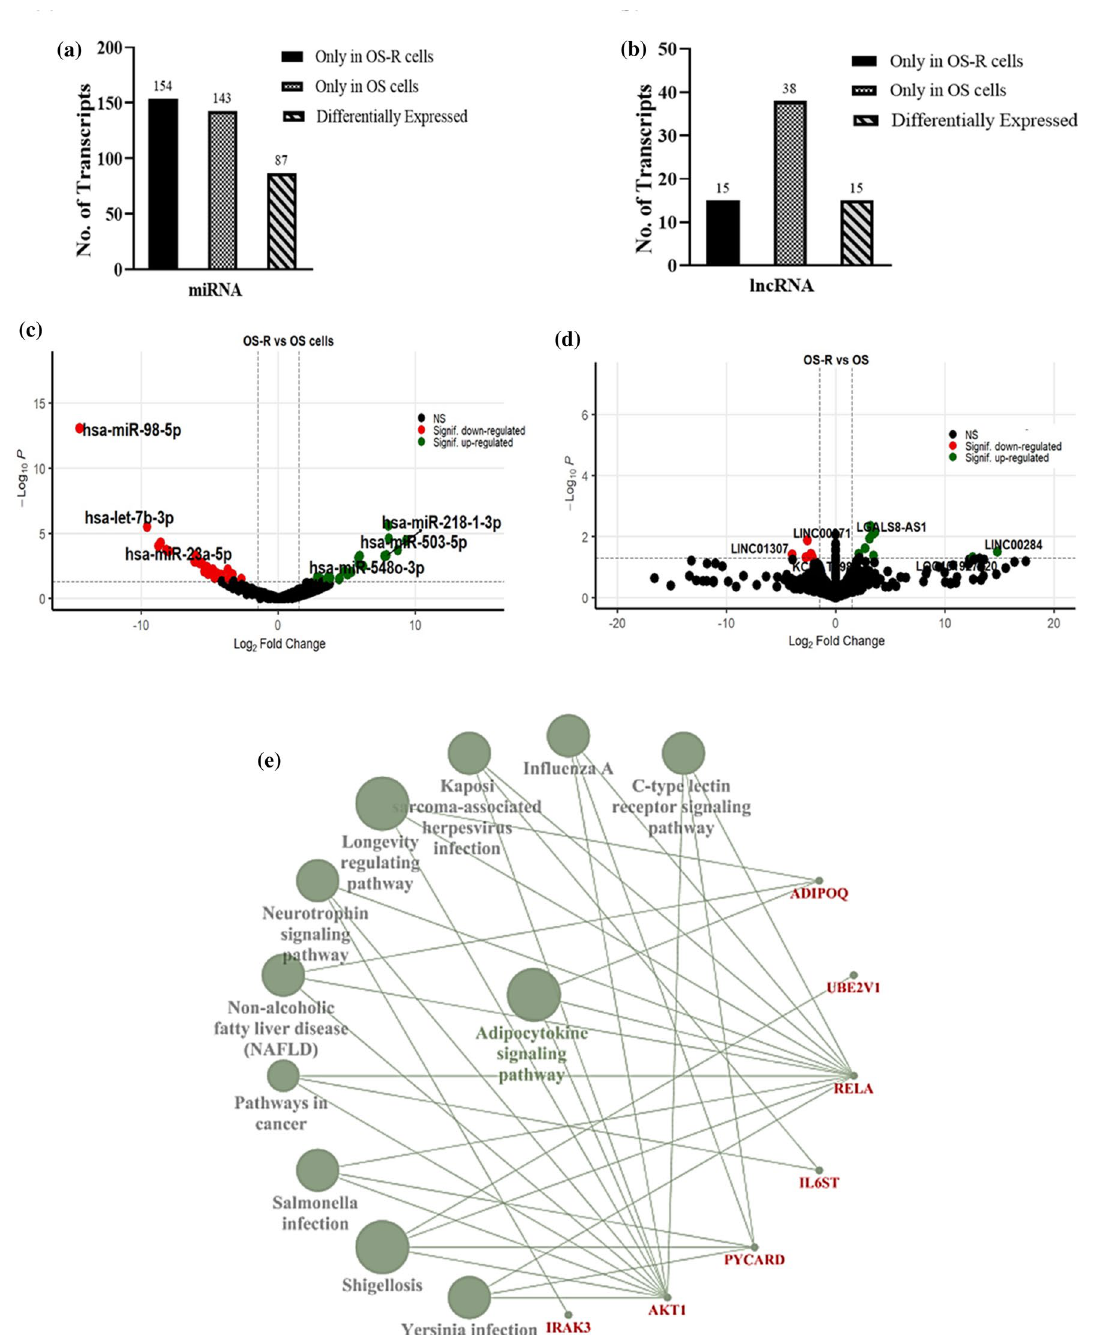
Fig. 4 Comparative transcriptomic analysis of drug-resistant cells (OS-R) and untreated controls (OS). The bar graph represents the a miRNA transcript and b lncRNA transcript distribution representing the treatment-specific, control-specific and differentially regulated transcripts. In each case, transcripts with a p-value ≤ 0.05 were considered. A volcano plot representing the upregulated (green dots) and downregu- lated (red dots) c miRNA transcripts and d lncRNA transcripts is shown. The names of the top three up- and downregulated miRNA and lncRNA transcripts are mentioned within the plot. Horizontal and vertical dashed lines indicate significance threshold corresponding to an adjusted p-value of ≤ 0.05 and log2fold change of ± 1.5 e Cytoscape network showing key genes (red font) and its pathways regulated by significantly dysregulated miRNAs in OS-R vs. OS set. miRNA-regulated key genes are involved in regulating the adipocytokine signaling pathway and B-cell receptor signaling